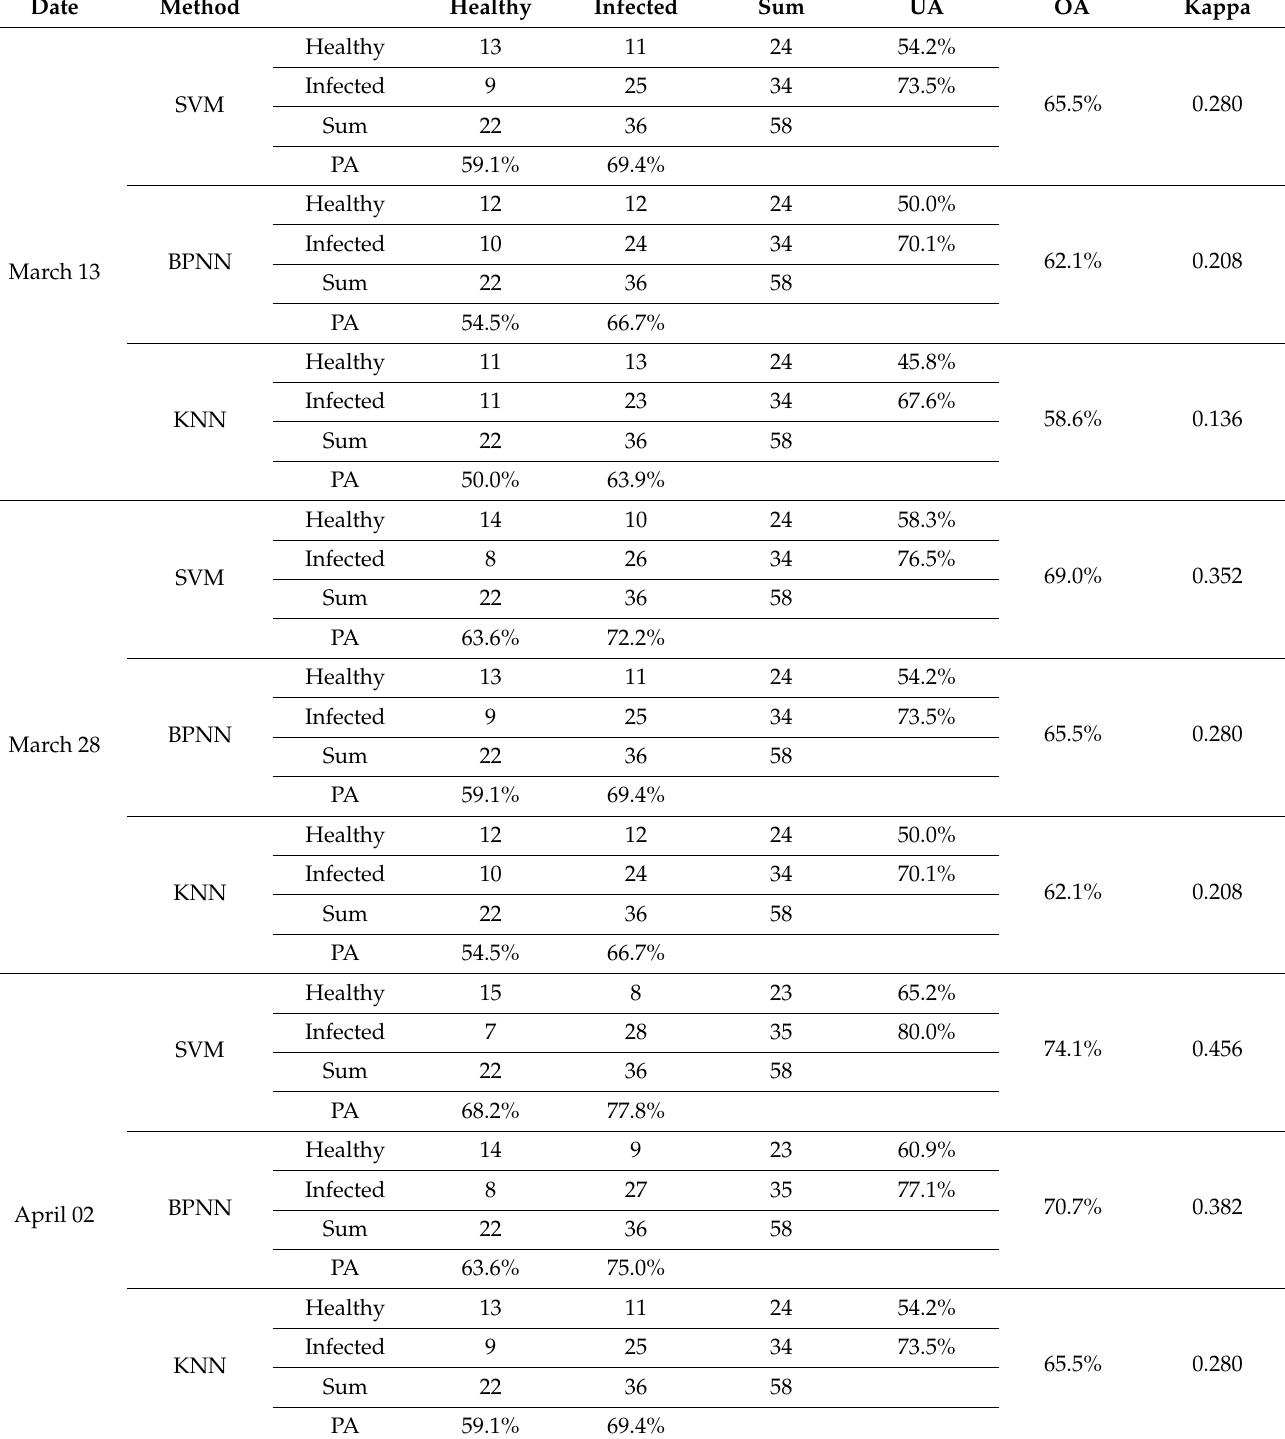
Table 7. Prediction model validations on (a) March 13; (b) March 28; (c) April 02; (d) April 22; and (e) April 27, based on the support vector machine (SVM), k-nearest neighbor (KNN), and back propagation neural network (BPNN) methods, using the optimal vegetation indice